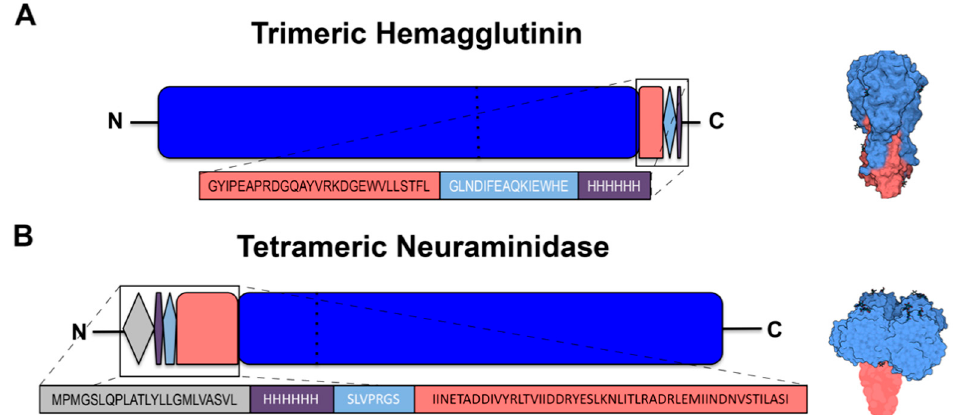
Figure 1. ( A ) Schematic of the design of the recombinant trimeric hemagglutinin. The N-terminus of the truncated HA protein (blue) is modified by the FoldOn trimerization domain (salmon) followed by the Avi-Tag (light blue) and 6 × His-Tag (violet) regions. Separating dotted line inside HA indicates the HA1 head region (N-terminus) versus the HA2 stem region (C-terminus) also depicted in light blue and salmon, respectively, on the 3D drawing on the right. ( B ) Schematic of the design of the recombinant tetrameric neuraminidase. The CD5 signal sequence (grey) is at the N-terminus of the protein, followed by the 6 × His-Tag (violet) and the thrombin cleavage site (light blue) sequences, which are followed by the tetrabrachion domain (salmon) linked to the stem region of the truncated neuraminidase protein (blue). Dotted line indicates the head region (C-terminus) and stem region (N-terminus) also depicted in light blue and salmon, respectively, on the 3D drawing on the right. Figure generated with Biorender.